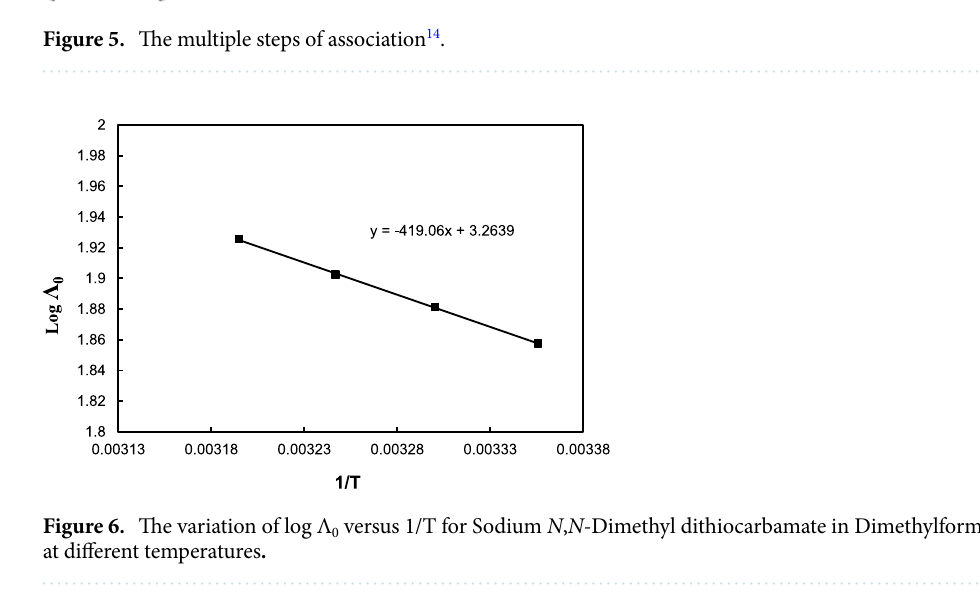
(1) y = -3921.3x + 14.506